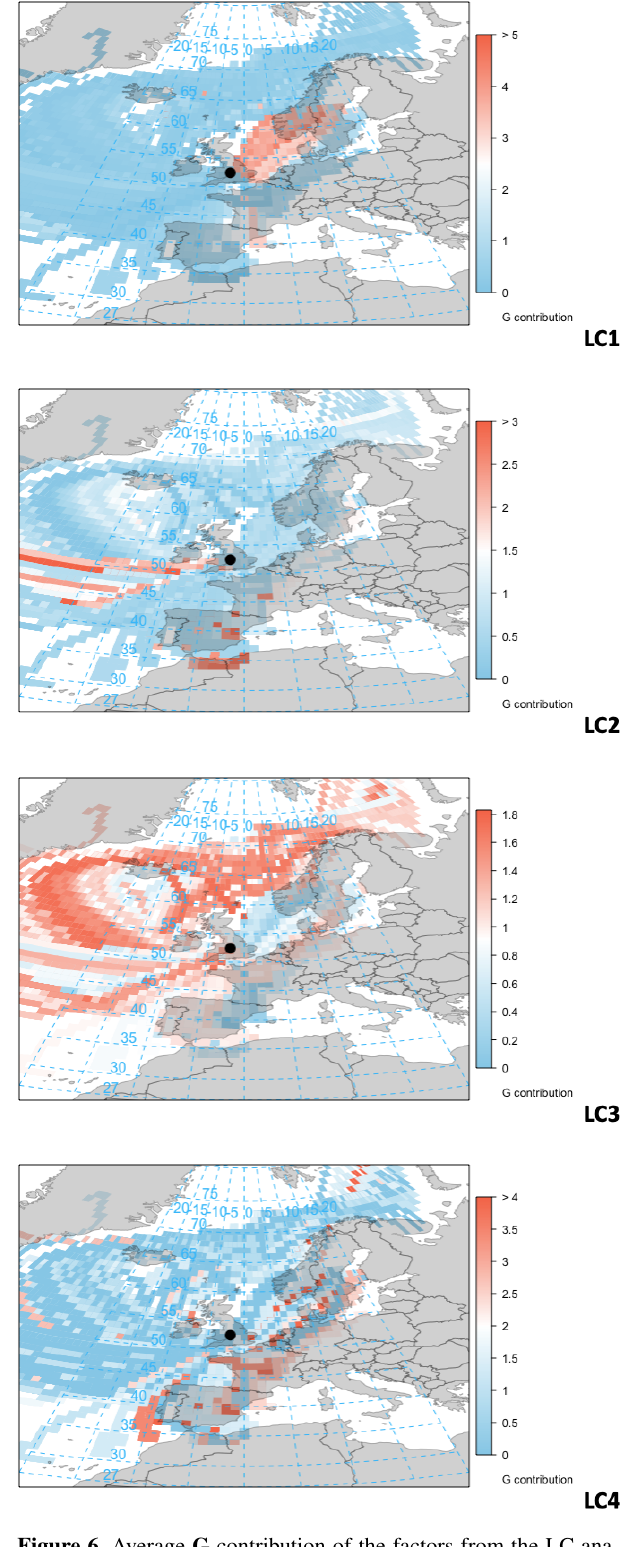
Figure 6. Average G contribution of the factors from the LC ana- lysis for incoming air masses. Higher contributions indicate better association of the given factor with the corresponding air mass ori-